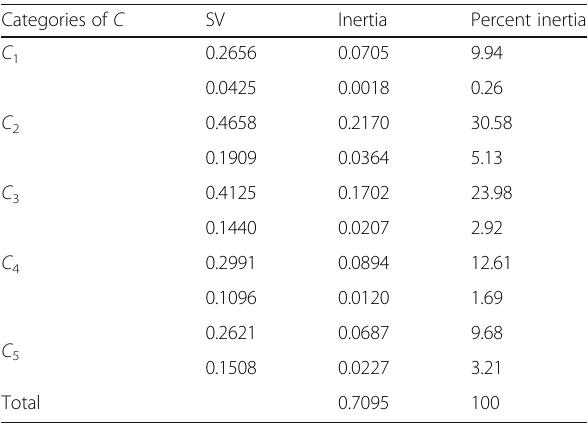
Table 10 Results of MCA based on separate SVDS for Table 9 along B and A across the categories of C Categories of C